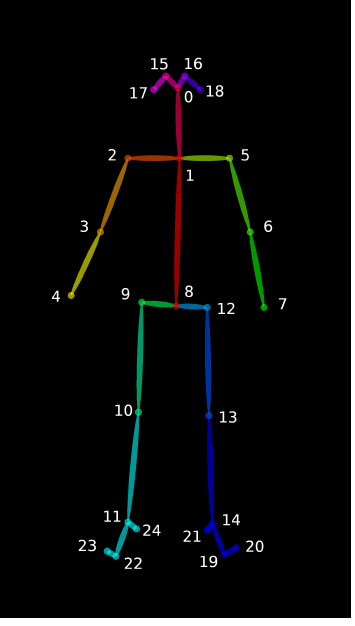
Figure 3. OpenPose 25 keypoints model [9]. Table 3. The 12 basic keypoints of the appendicular